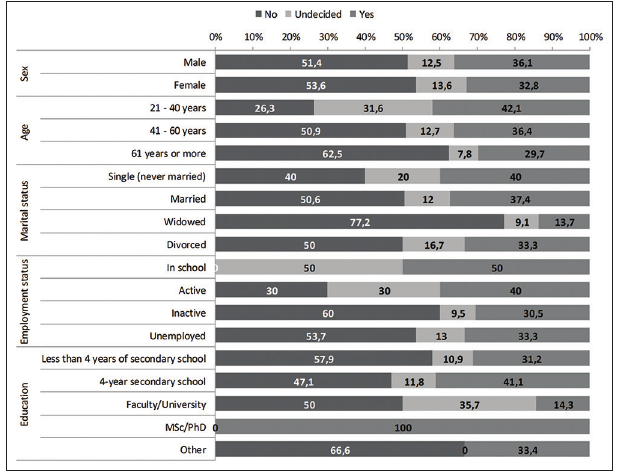
FIGURE 1. The percentage of aesthetic repair of arteriovenous fistula (AVF) affected by pseudoaneurysm in relation to the gender, age, education, employment and marital status of chronic hemodialysis